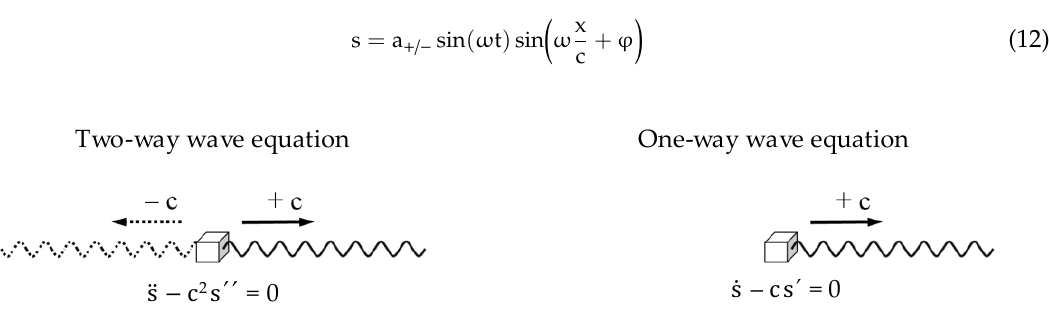
Figure 1. 1D-waveguide with sinusoidal wave propagation (single waveguide element is displayed): Two-way wave equation with two solutions according to the wave velocities + c and –c vs. One-way wave equation with one unique solution acc. to the chosen wave velocity c (here: + c).